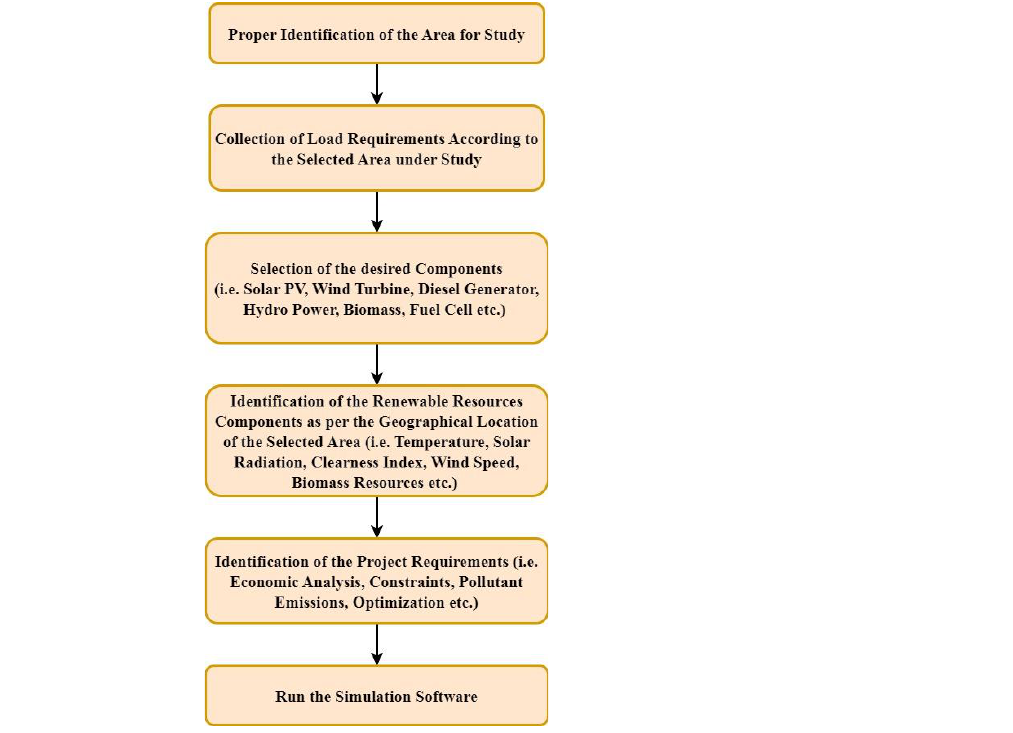
Figure 1. Steps to design an integrated energy system.